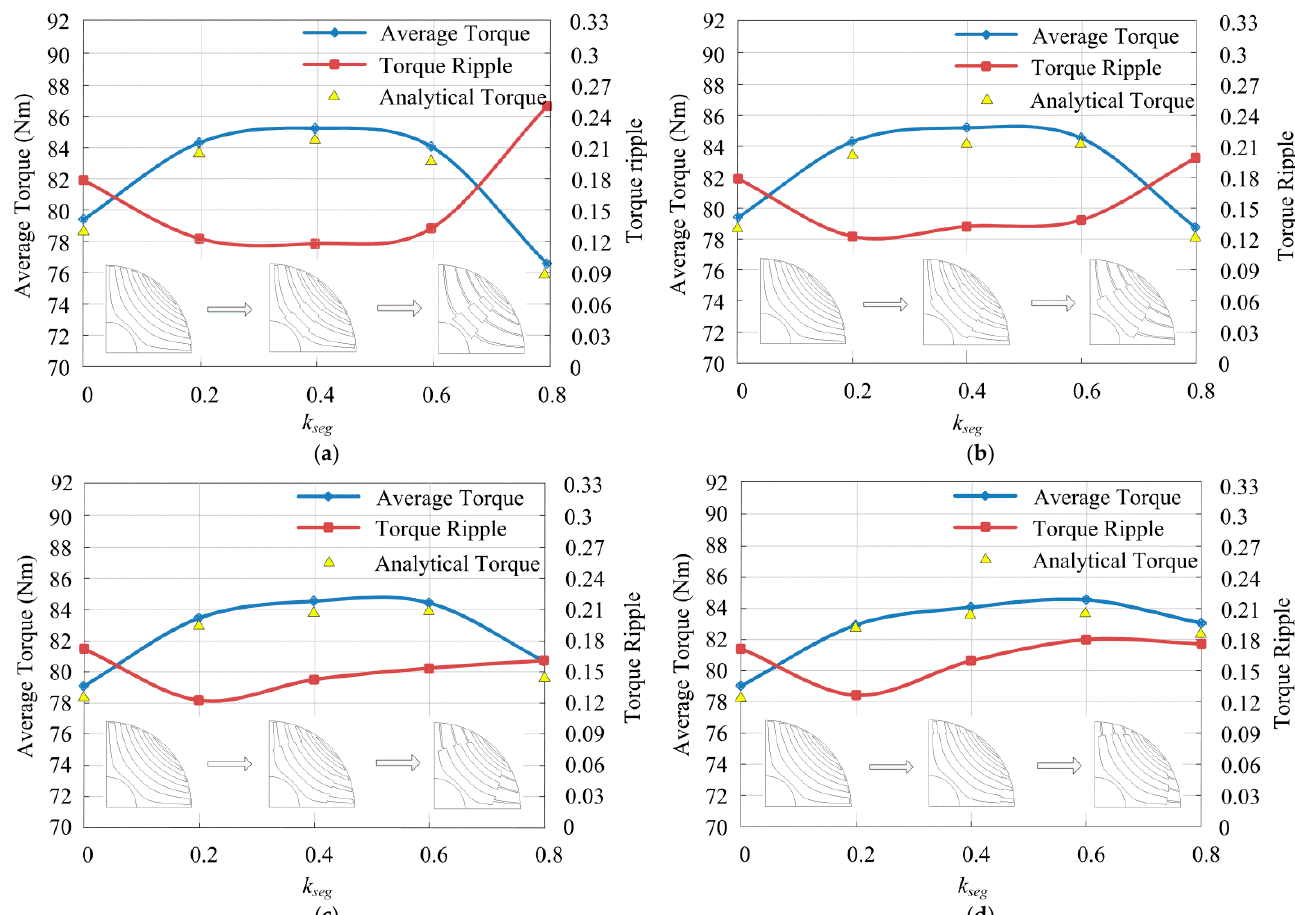
k on average torque and torque ripple: ( a ) = 0.2 k and Figure 10. The effect of arc seg = 0.4 k ; ( c ) = 0.6 k ; ( d ) = 0.8 k . ( c ) k arc = 0.6; ( d ) k arc = arc arc arc